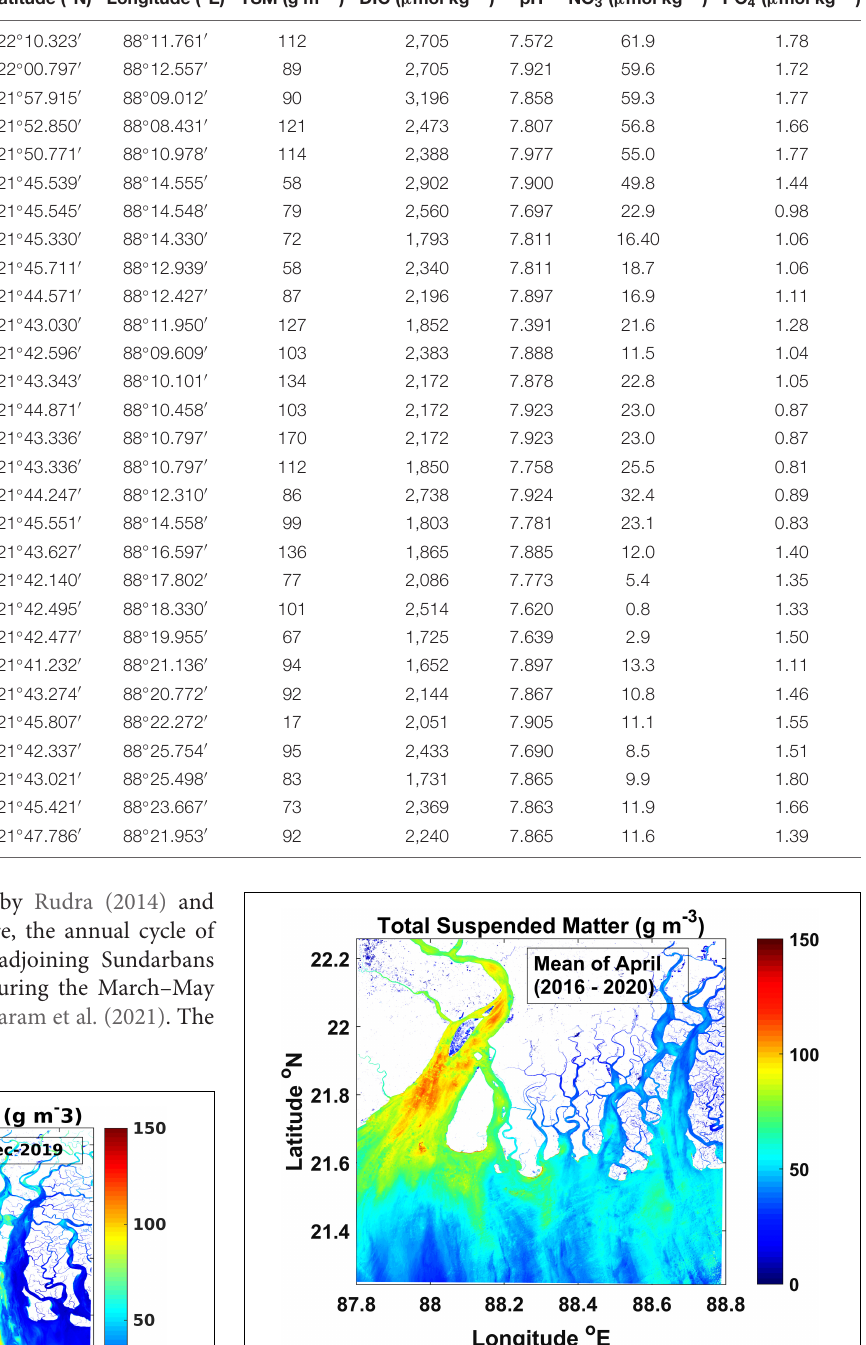
FIGURE 3 | The TSM concentration derived from Landsat-8 data pertaining to December 16, 2019.